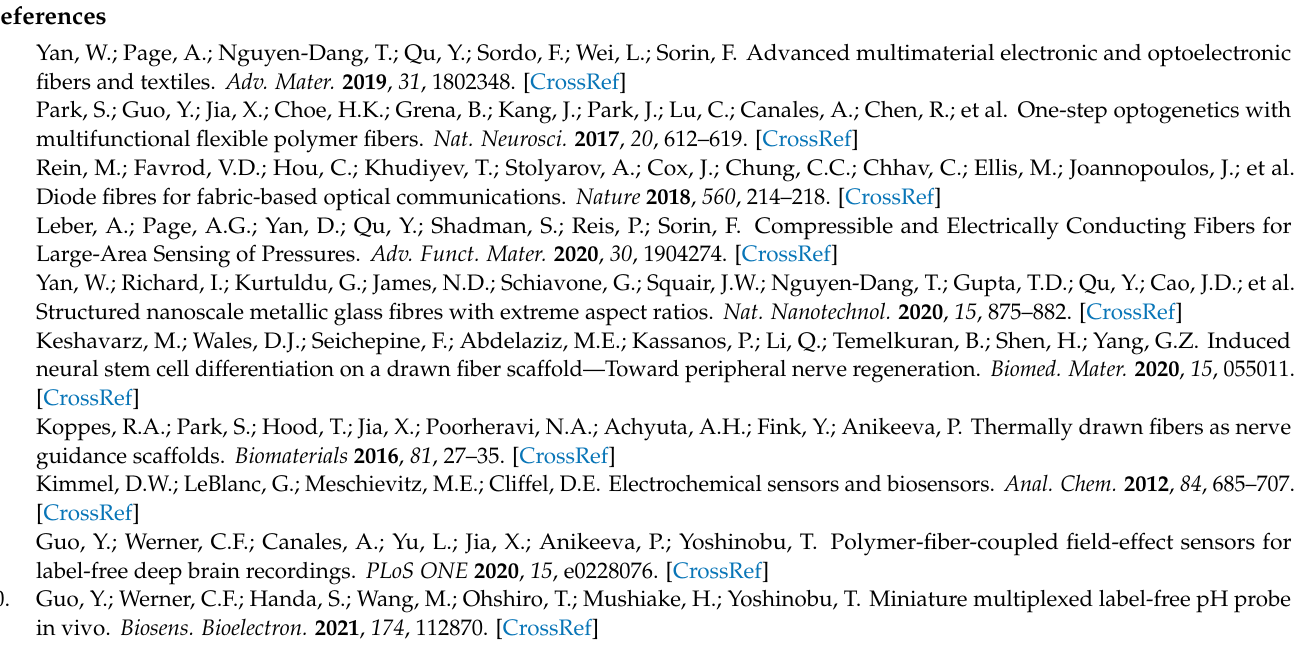
Figure S4: The cyclic voltammograms of the fiber sensors with 10 wt% CNT nanocomposites (N = 4). Figure S5: The Na + sensing characterization of the ion-sensitive membrane functionlized CNT composite fibers in the physiological